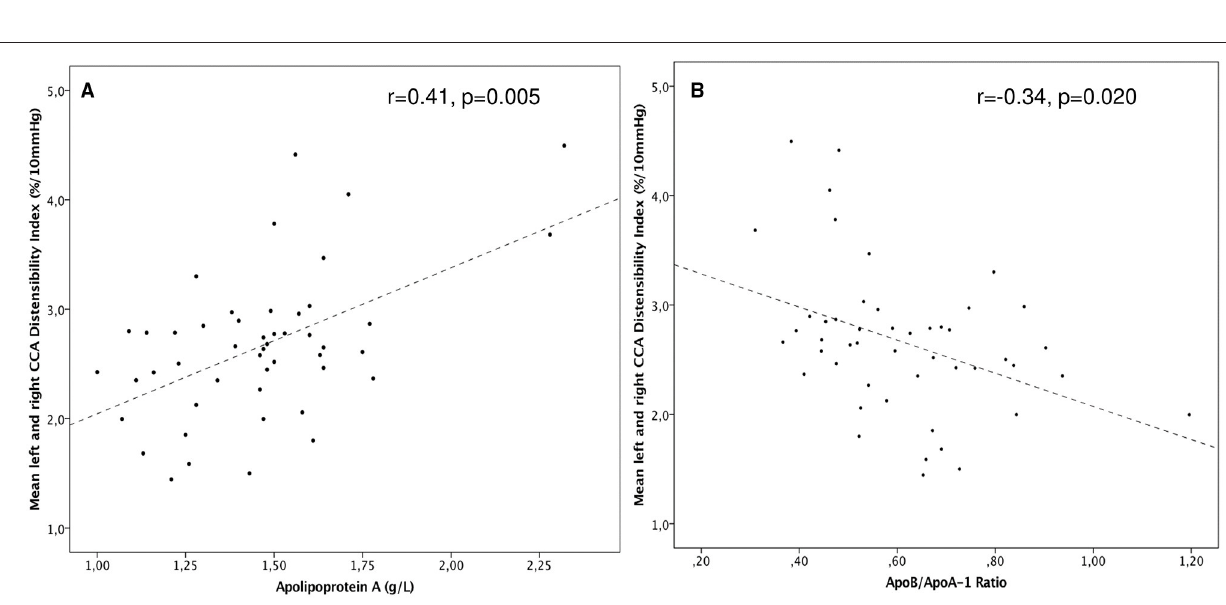
Frontiers in Pediatrics |